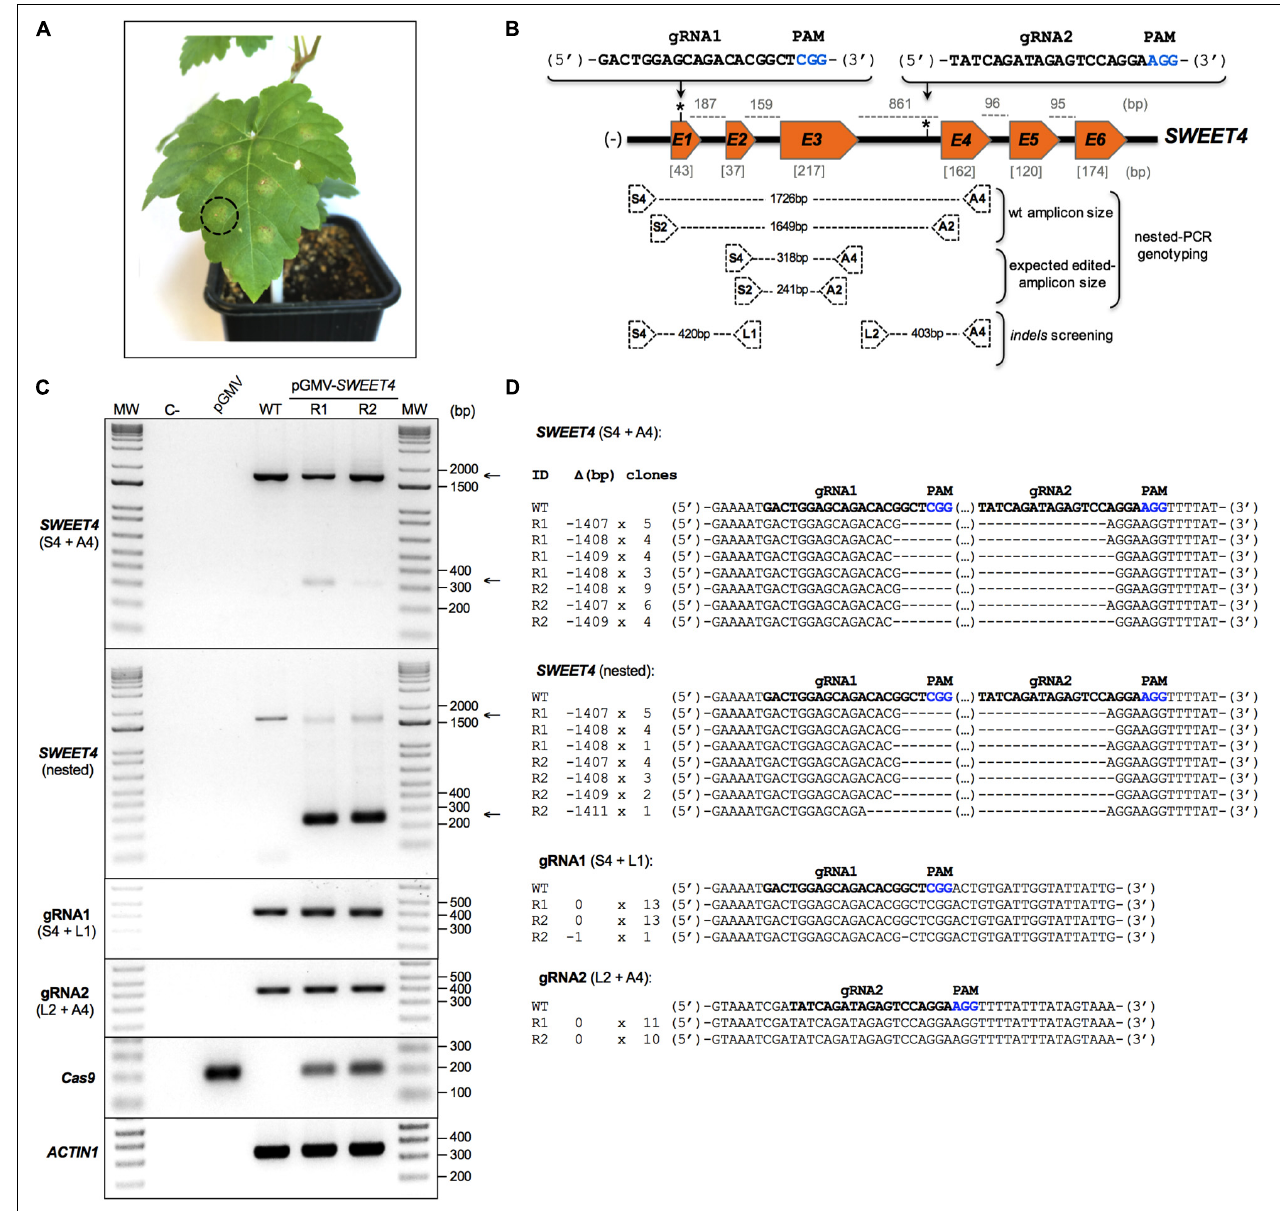
FIGURE 3 | SWEET4 gene editing in agroinfiltrated ‘Thompson Seedless’ leaves. (A) The black dotted circle indicates an agroinfiltration point on a grapevine leaf. (B) Schematic illustrating both the mutagenesis target sites in the SWEET4 gene and nested-PCR-based large deletion detection strategy. Exon (orange boxes) and intron (black line between exons) sizes (bp, base pair) are indicated in gray square brackets and gray dotted lines, respectively. The asterisks indicate the position of the selected gRNA pair for the SWEET4 gene editing. The gRNAs sequences are shown in bold, and the PAM sequences are highlighted in blue. The location of the primers (black dotted boxes) and the amplicons size (black dotted lines) are shown in a schematic; (–), gene orientation. (C) Identification of CRISPR/Cas9-induced mutations in agroinfiltrated grapevine leaves by both direct- and nested-PCR. Genomic DNA from leaf agroinfiltration points was purified and subjected to a first PCR amplification (direct-PCR) using S4 and A4 primers (first upper panel). The PCR products of the primary amplification were then used in a secondary PCR (nested-PCR) using a S2 and A2 primers (second upper panel). The indel detection used PCR amplification of gRNA1 (first middle panel) and gRNA2 (second middle panel) target zones using S4 + L1 and L2 + A4 primers, respectively. Arrows (right side of the panel) show the expected edited (lower) and non-edited (upper) versions of the VviSWEET4 gene. These amplicons were cloned and sequenced for further analysis (D) . PCR detection of Cas9 gene was used to confirm or rule out T-DNA integration (first lower panel). In this case, Cas9 amplicons were detected in all the agroinfiltrated leaf samples due to a coexistence of both Agrobacterium and plant DNAs. VviACTIN1 was used as a reference gene (second lower panel). All PCR-products were resolved in 1.5% electrophoresis agarose gels. MW, molecular weight marker; C-, negative control (water); pGMV, empty vector control; WT, wild type; R, biological replicate. (D) Different types of mutations detected in agroinfiltrated grapevine leaves after CRISPR/Cas9-mediated SWEET4 genome editing. The columns on the left indicate the sample identification (ID), the deletion size ( (cid:49) ), and the numbers of clones sequenced (clones). The gRNAs sequences are shown in bold, and the PAM sequences are highlighted in blue.